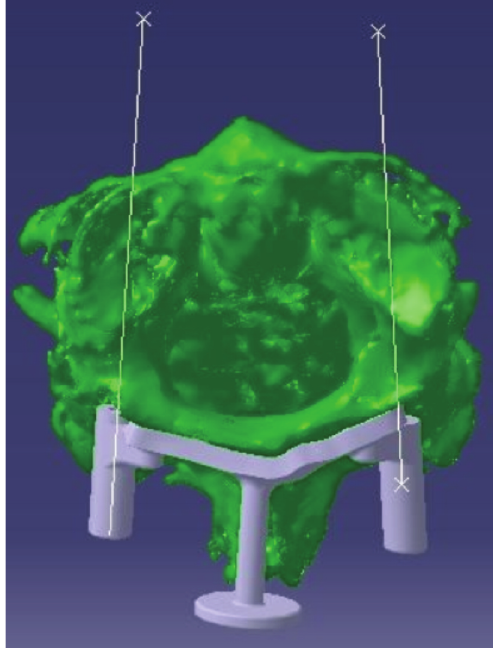
Templates designed based on the path of the screws. The lines represent the pre-specified path. Fig. 6: